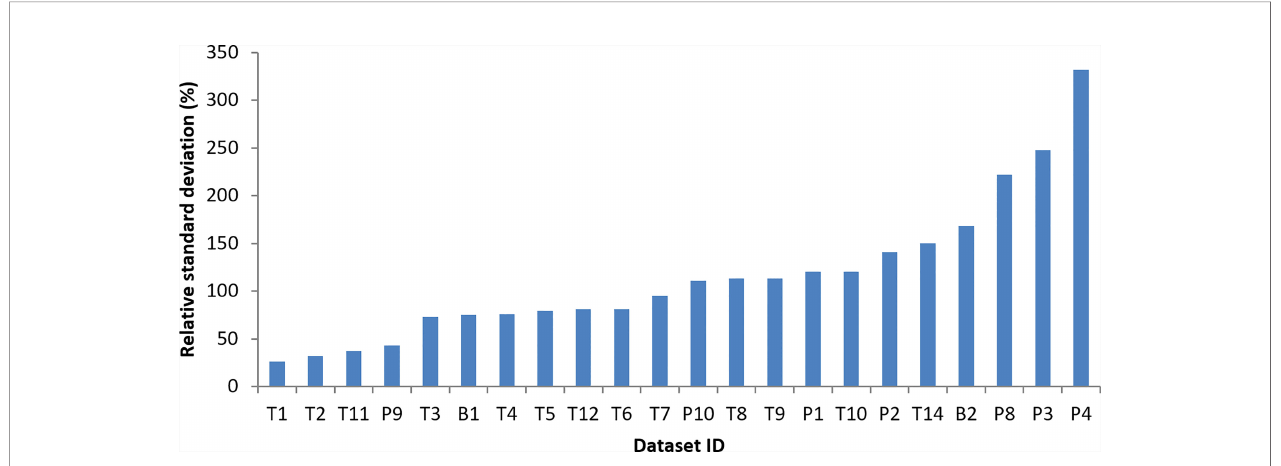
FIGURE 5 | Relative standard deviation of microplastic particle concentration derived from 22 microplastic